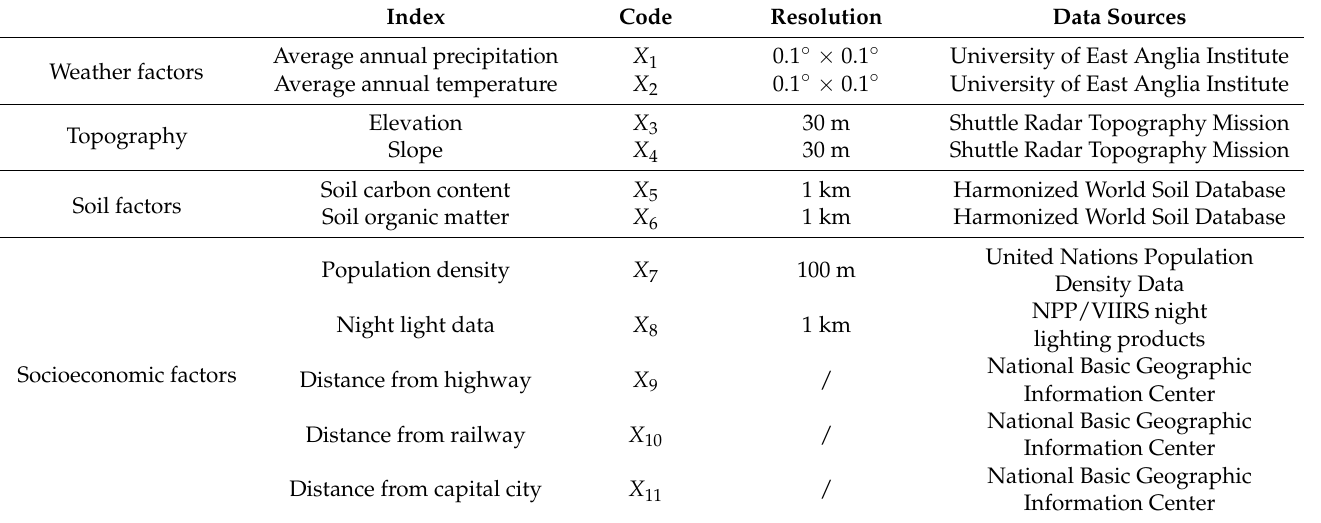
Table 2. Driving